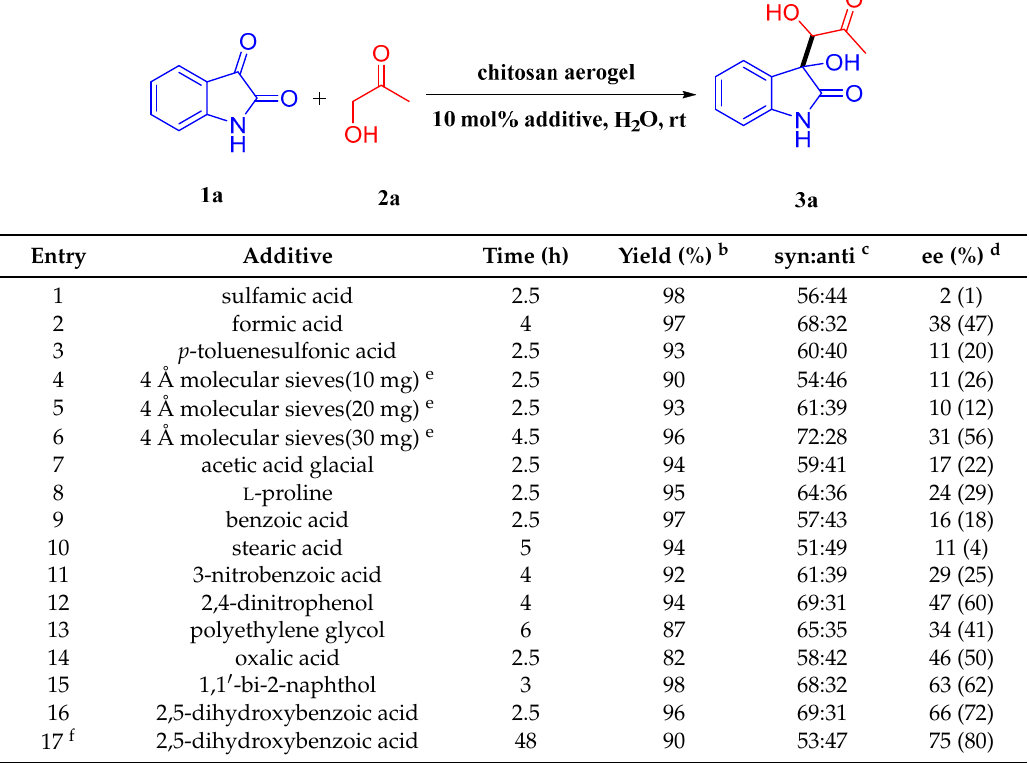
Table 3. Effects of additives for the enantioselective aldol reaction in the presence of water a .